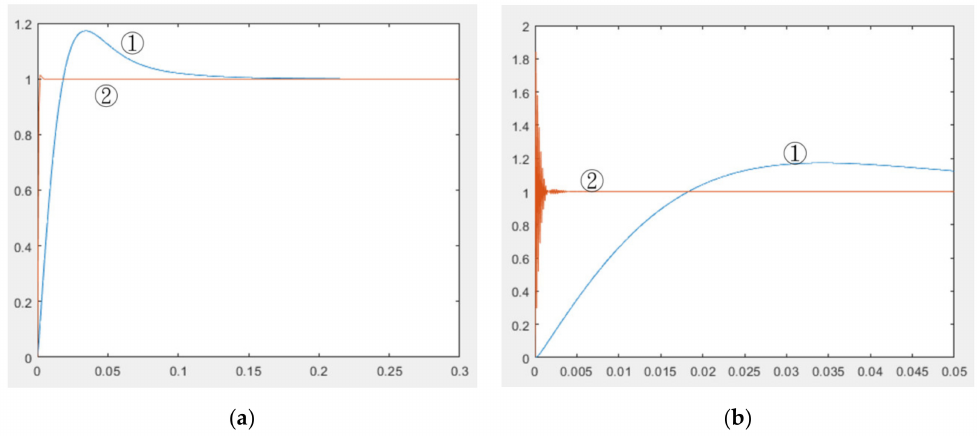
Figure 9. Step response ( a ) with a sampling time of 1 ms and ( b ) with a sampling time of 0.1 ms.